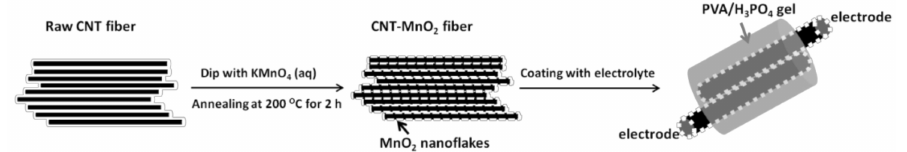
Figure 1. Schematic diagram of the manufacturing method of the CNT–MnO 2